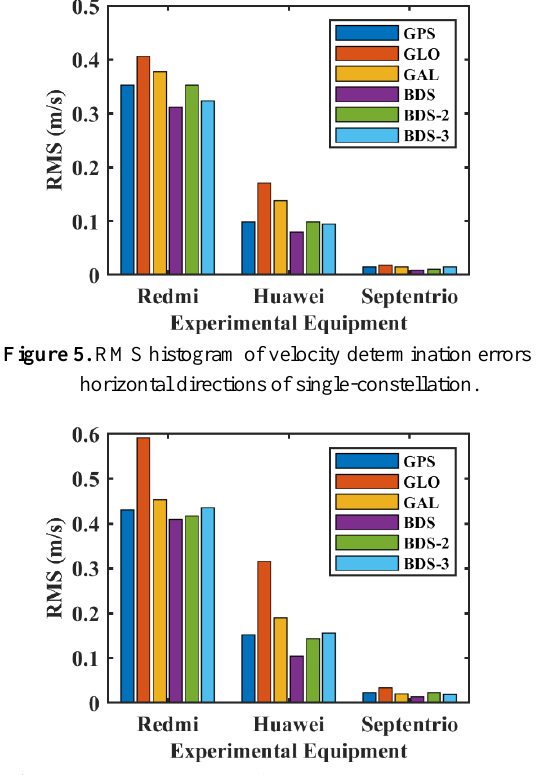
Figure 6. RMS histogram of velocity determination errors in vertical directions of single-constellation. Table 2. RMS of triple -constellation velocity